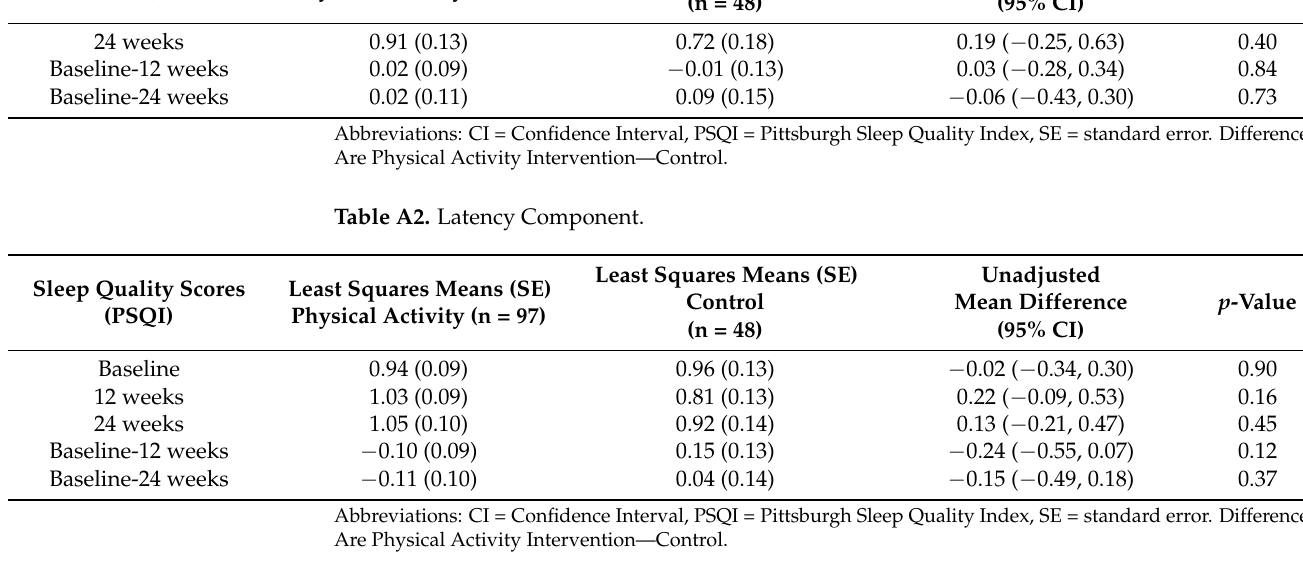
Table A3. Duration Component.